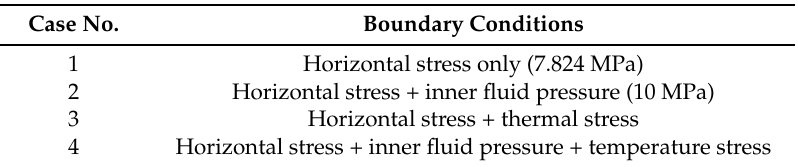
Table 4. Classification of applied boundary conditions. Case No.